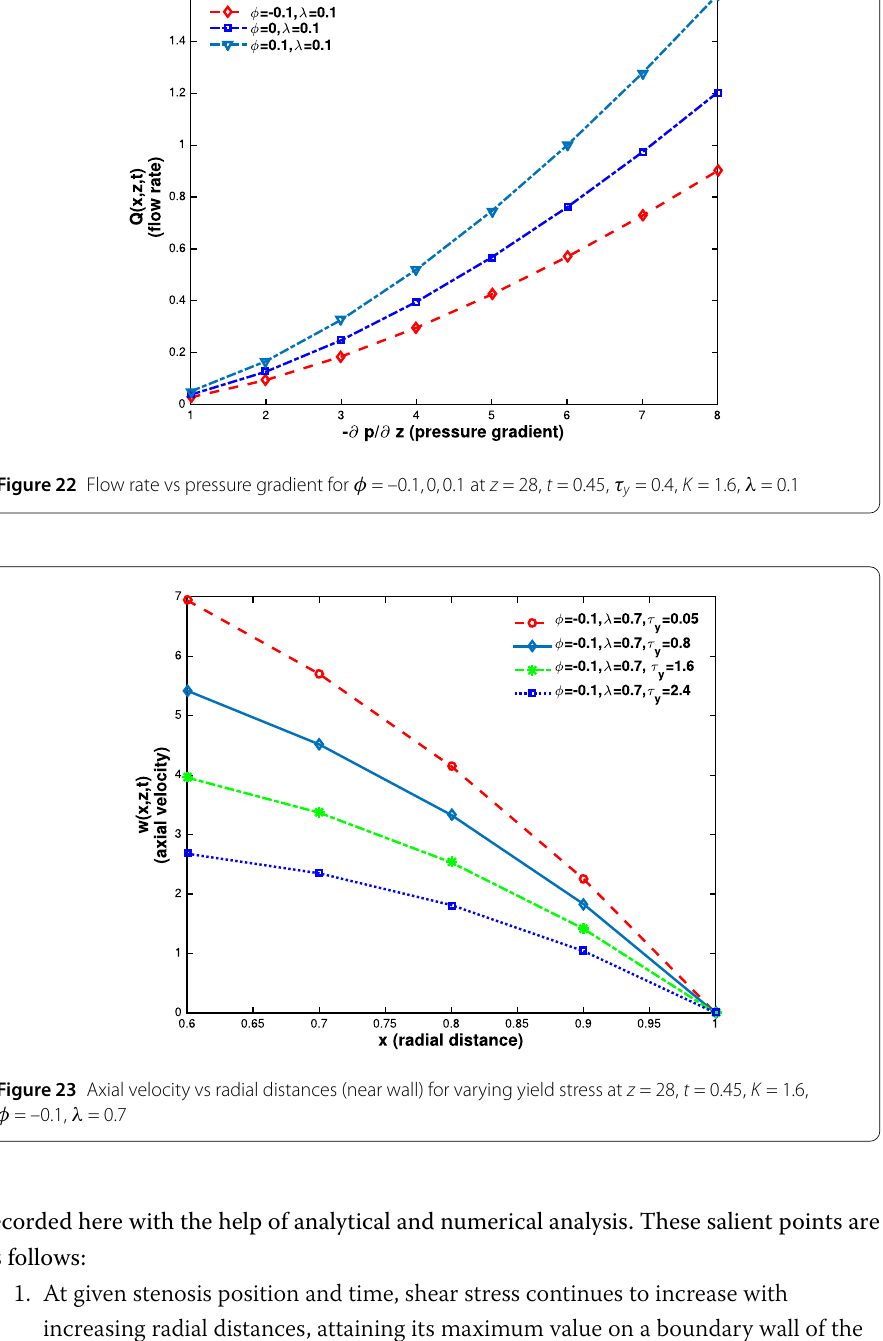
recorded here with the help of analytical and numerical analysis. These salient points are as